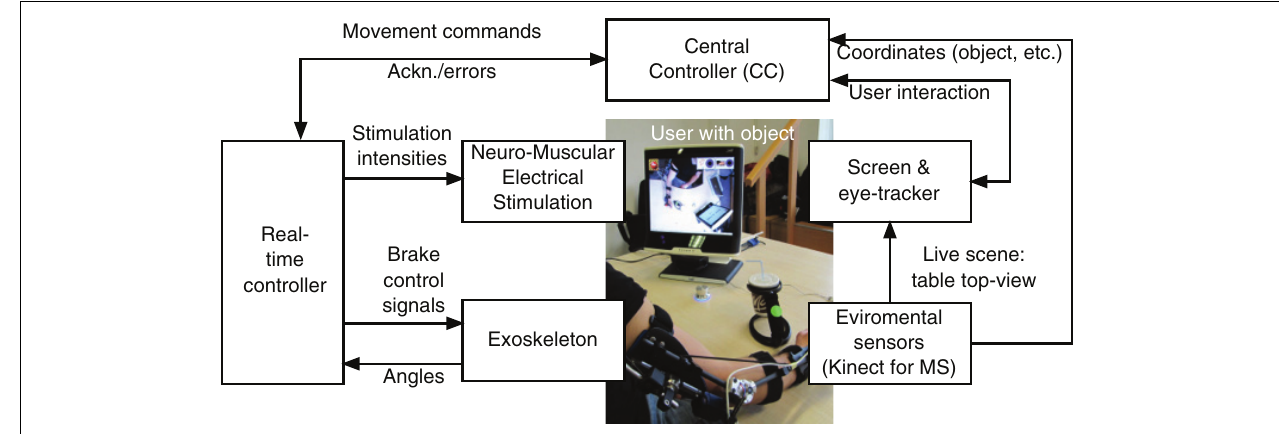
FIGURE 1 | System architecture for support of reaching